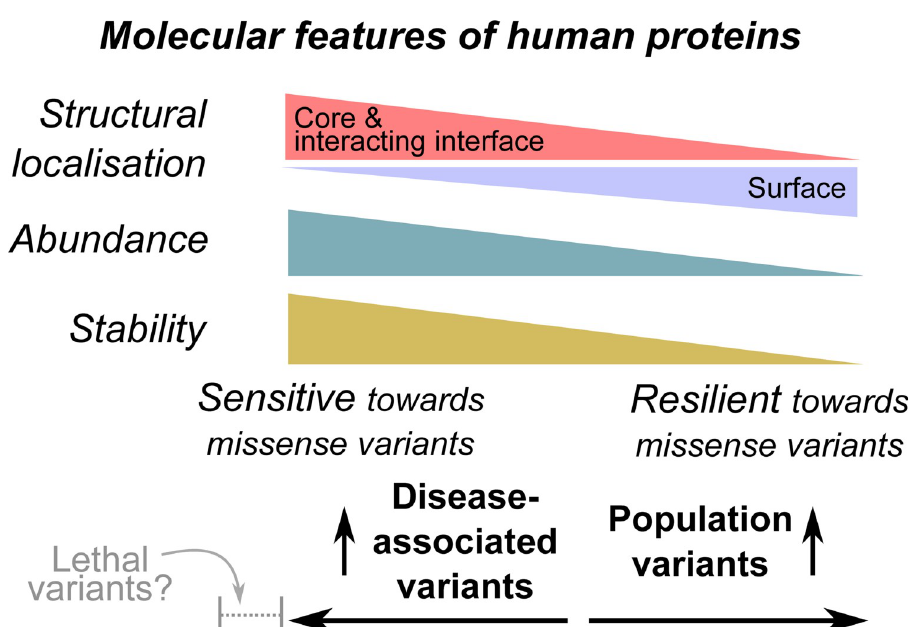
Fig 8. Summary of analyses. Here, we have explored patterns of structural localisation, abundance, and stability for proteins enriched in disease-associated and population variants respectively. These molecular attributes determine the resilience and sensitivity of the proteins towards missense variants (see